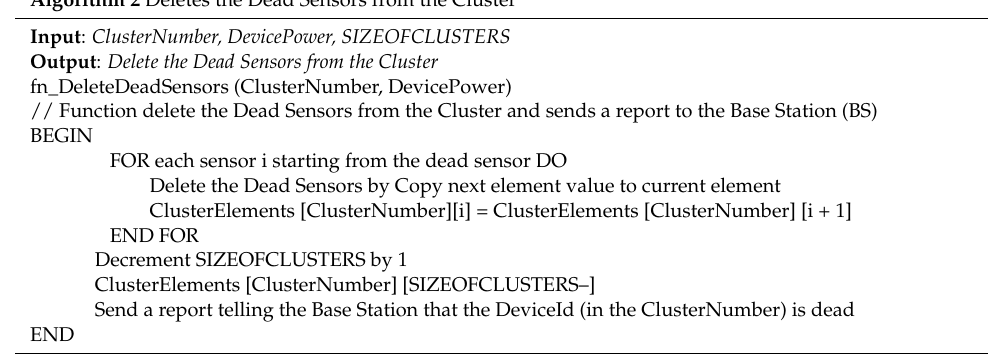
Algorithm 2 Deletes the Dead Sensors from the Cluster